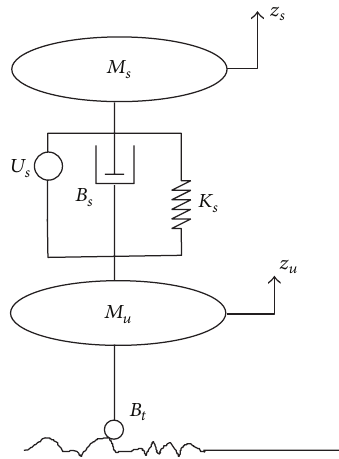
Figure 1: The active suspension